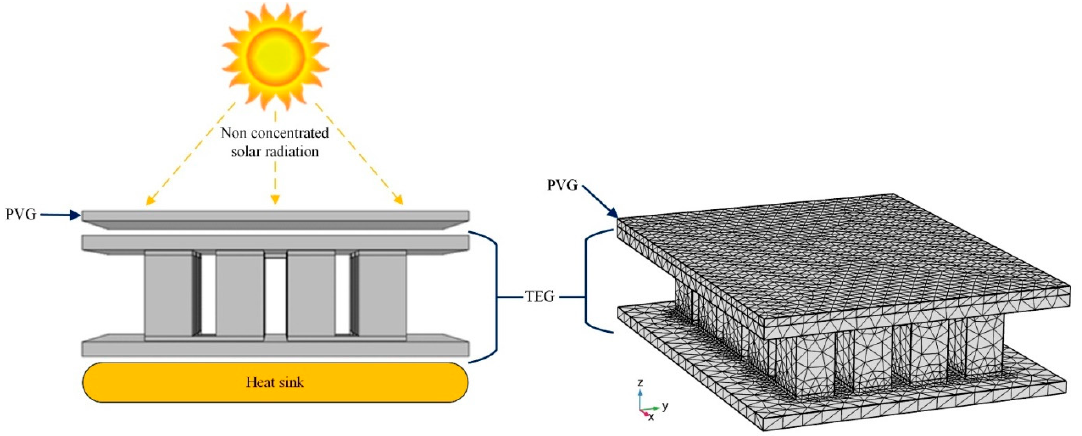
Figure 14. Free-concentrator STEG representative segment.